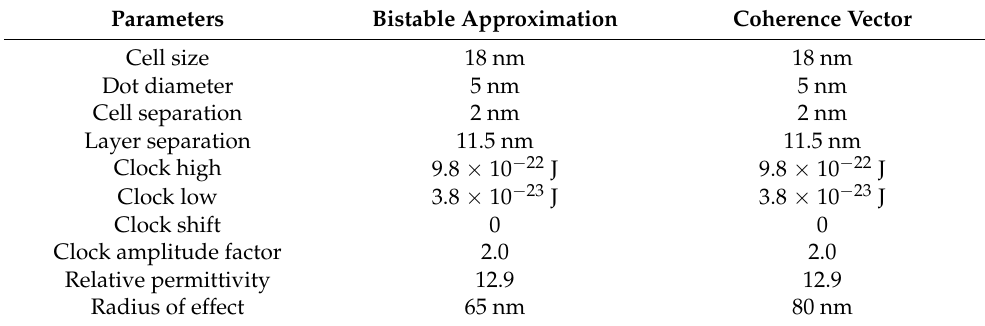
Table 4. Simulation parameters.